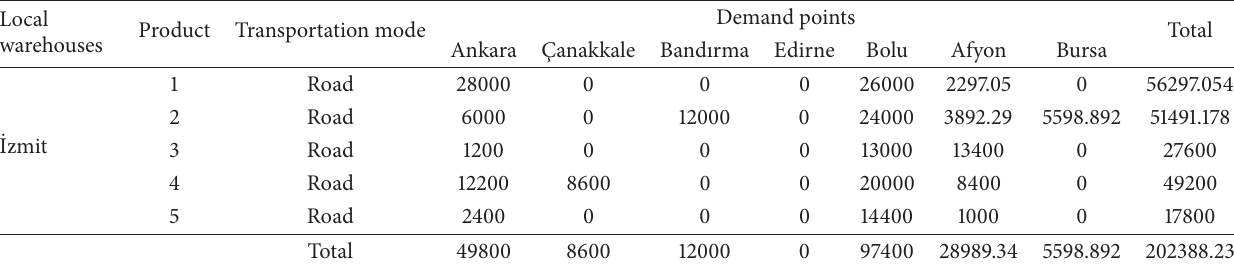
Table 24: Transportation quantities from local warehouses to demand